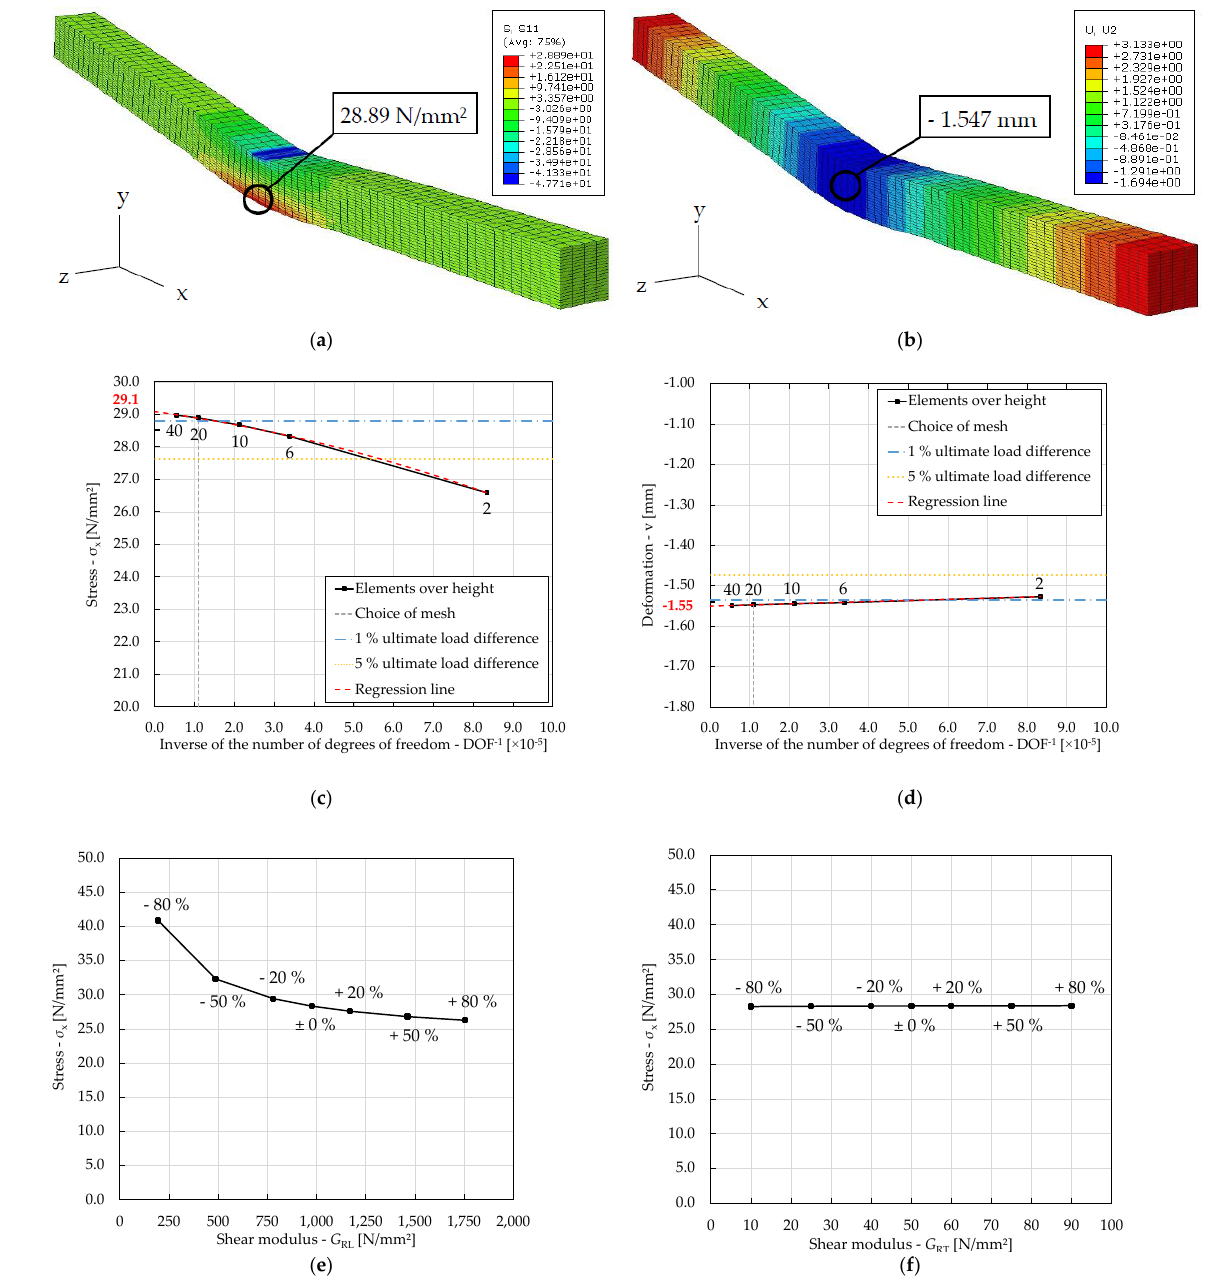
Figure 7. Model verification: (a) Longitudinal stress σ x (S11), BR_V1_600 mm; (b) Deformation v (U2, y-direction), BR_V1_600 mm; (c) Numerically determined maximum longitudinal stresses σ x when varying the number of elements over the height (plotted over the inverse of the number of degrees of freedom DOF − 1 ) for BR_V1_600 mm; (d) Numerically determined maximum displacements v (y-direction) when varying the number of elements over the height (plotted over the inverse of the number of degrees of freedom DOF − 1 ) for BR_V1_600 mm; (e) Numerically determined maximum longitudinal stresses σ x for variations of the shear modulus G RL for BR_V1_600 mm; (f) Numerically determined maximum longitudinal stresses σ x for variations of the shear modulus G RT for BR_V1_600 mm.